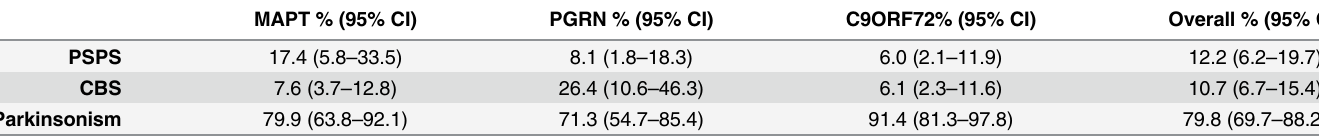
Table 4. Movement disorder syndromes present at any point during the FTLD disease course stratified based on genetic